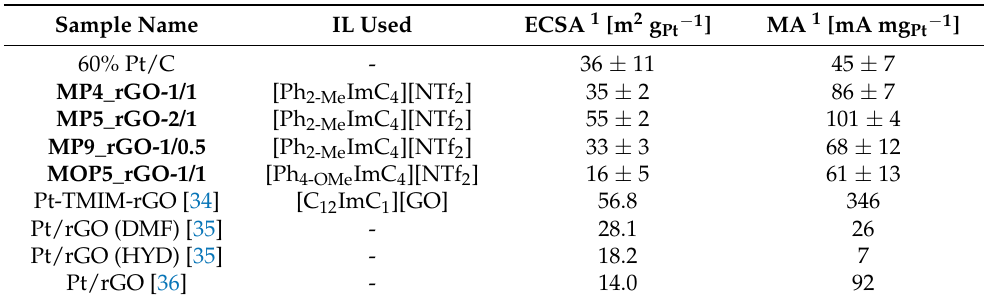
Figure 4. Results obtained via electrochemical measurements: ( a ) averaged cyclic voltammetry (CV) in N 2 -atmosphere and at 20 mV s −1 sweep rate of the four samples MP4_rGO-1/1 , MP5_rGO-2/1 , MP9_rGO-1/0.5 , MOP5_rGO-1/1 , and a Pt/C 60% standard material; ( b ) averaged oxygen reduction reaction (ORR) polarization curves (linear sweep voltammetry (LSV)) of the same samples in O 2 - saturated atmosphere at 10 mV s −1 sweep rate. From these data, ( c ) the electrochemical surface area (ECSA) and ( d ) the mass-specific activity (MA) at 0.9 V were calculated. Table 2. Electrochemical surface area (ECSA) and mass-specific activity (MA) of Pt-NP@rGO synthe- sized with and without